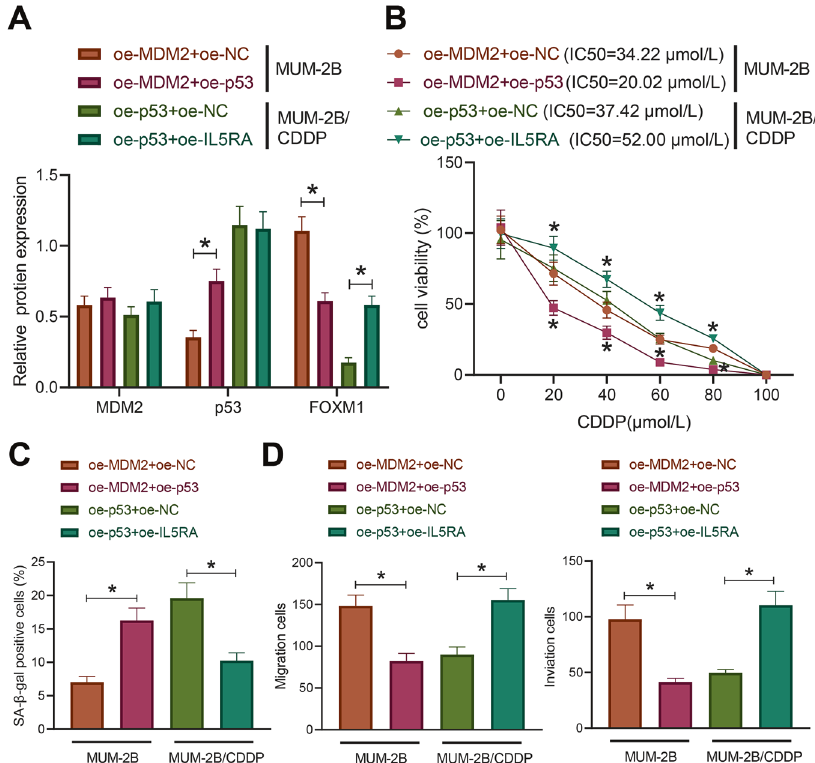
Fig. 5 MDM2 promotes CDDP resistance in uveal melanoma cells through regulation of the p53/IL5RA axis. A The expression of MDM2, p53, and IL5RA in MUM-2B and MUM-2B/CDDP cells with different treatments as measured by Western blot assay. B The viability and IC50 of MUM-2B and MUM-2B/CDDP cells with different treatments as examined by CCK-8 assay. C The senescence rate of MUM-2B and MUM-2B/ CDDP cells with different treatments as assessed by SA- β -gal staining. D The migration and invasion abilities of MUM-2B and MUM-2B/CDDP cells with different treatment as examined by Transwell assay. * p < 0.05. Cell experiments were repeated three times